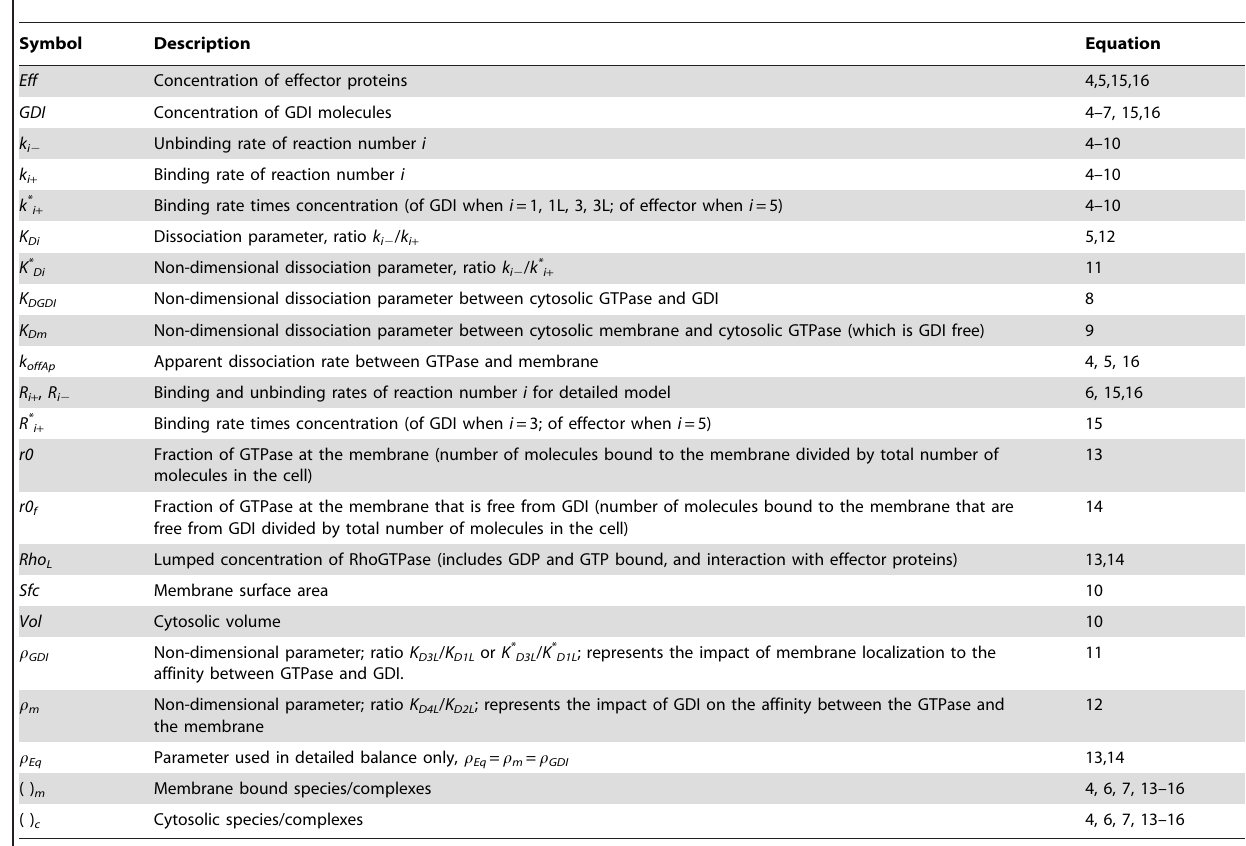
Table 2. Variables and parameters used in lumped and detailed models.